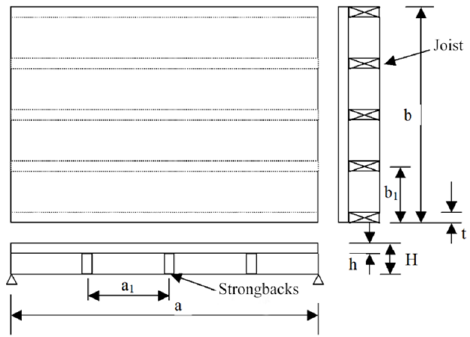
Figure 14. Timber floor ribbed slab model.